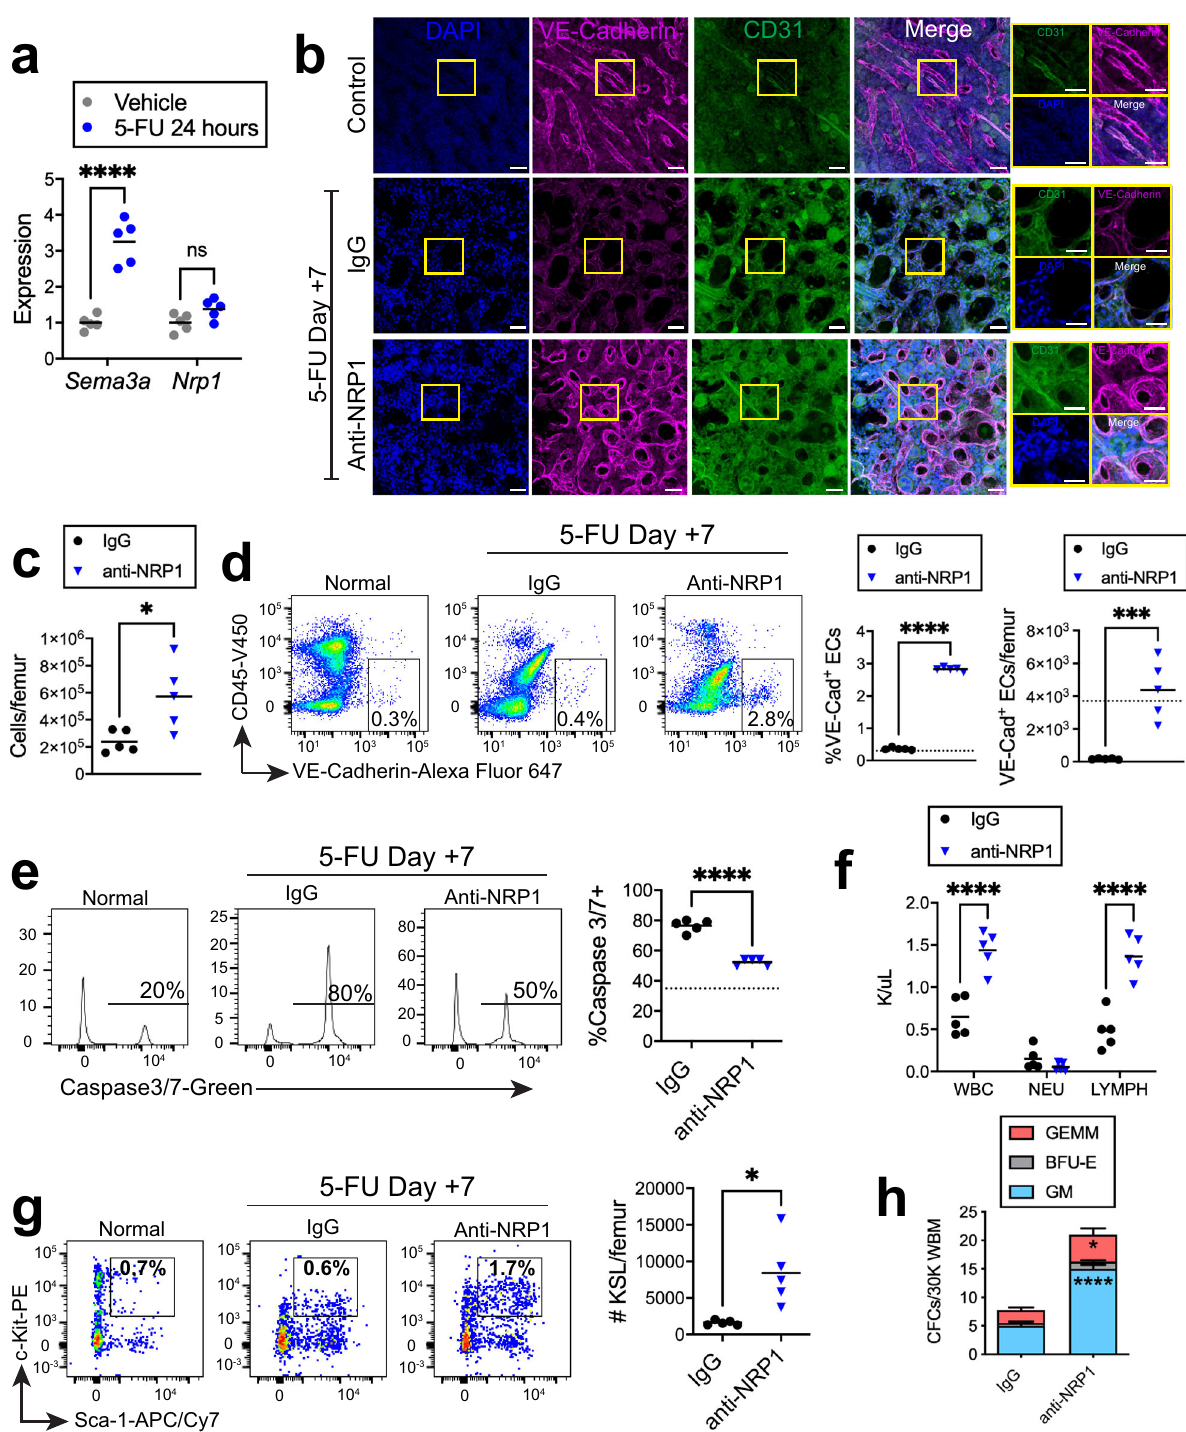
apoptosis in vitro, suggesting that SEMA3A-mediated induction signi fi cant increase in Cdk5 phosphorylation in BM ECs at 1 h of BM EC apoptosis was dependent on Cdk5 (Fig. 6d). following irradiation with 800 cGy (Fig. 6c). Treatment with In neurons, Cdk5 phosphorylates the tumor suppressor, p53, SEMA3A further increased Cdk5 phosphorylation in BM ECs, causing stabilization of p53 and increased neuronal cell whereas anti-NRP1 treatment suppressed TBI-induced and death 69,70 . We detected increased phosphorylation of p53 in SEMA3A-induced phosphorylation of Cdk5 in BM ECs (Fig. 6c). BM ECs in response to irradiation and a further increase with Irradiation and SEMA3A treatment both increased CD31 + BM SEMA3A treatment (Fig. 6e). Treatment with anti-NRP1 EC apoptosis in vitro at + 24 h, whereas treatment with anti- abolished SEMA3A-mediated phosphorylation of p53 in irra- NRP1 abrogated these effects of irradiation and SEMA3A diated BM ECs (Fig. 6e). Similarly, treatment with roscovitine (Fig. 6d). Furthermore, treatment with roscovitine, a Cdk5 suppressed p53 phosphorylation in BM ECs in response to inhibitor 68 , abolished SEMA3A-mediated induction of BM EC NATURE COMMUNICATIONS| (2021) 12:6990